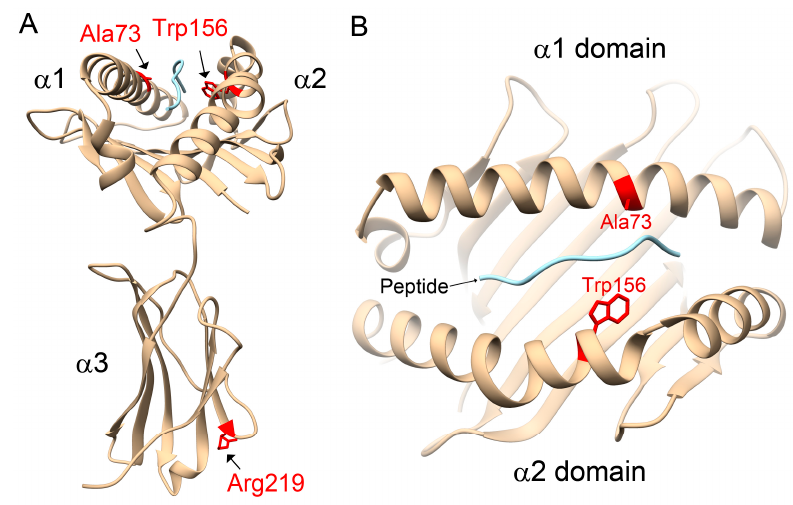
Figure 1. 3D Modeling of the α 1, α 2 and α 3 domains of human HLA-C*12:02:02 in complex with peptide. ( A ) The residues colored in red represent the unique amino acid polymorphisms Ala73, Trp156 and Arg219 of HLA-C*12:02:02 compared to HLA-C*01:02:01 and HLA-C*03:02:01. ( B ) View from the top of ( A ). The Ala73 and Trp156 polymorphisms are located in the peptide-binding groove between the α 1 and α 2 domains and interact with the peptide presented by HLA-C*12:02:02.